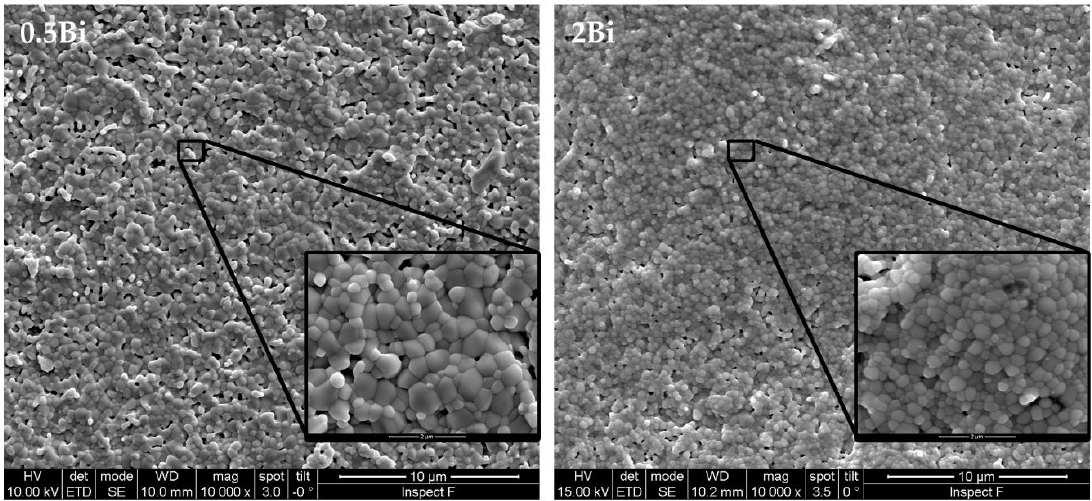
Figure 3. SEM micrographs of samples 0.5Bi and 2Bi sintered at 1250 °C for 3 h.